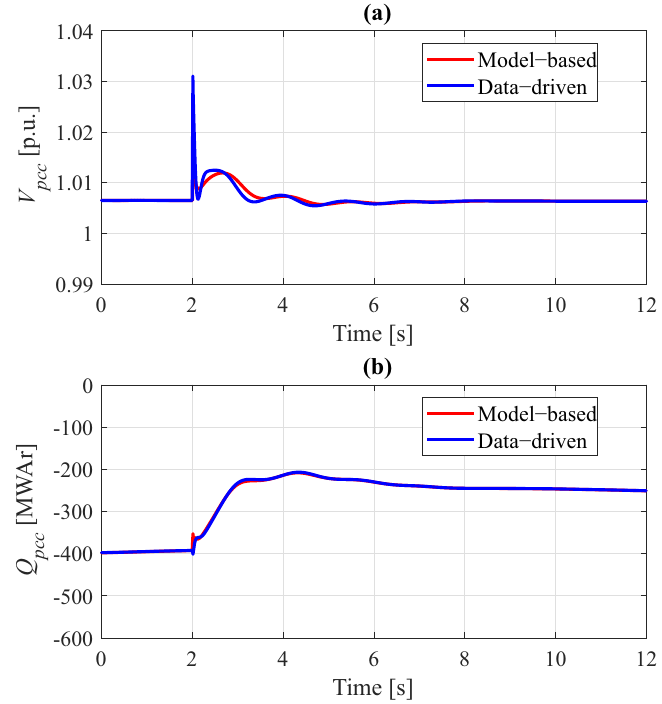
Figure 16. STATCOM: ( a ) AC voltage, and ( b ) reactive power during load